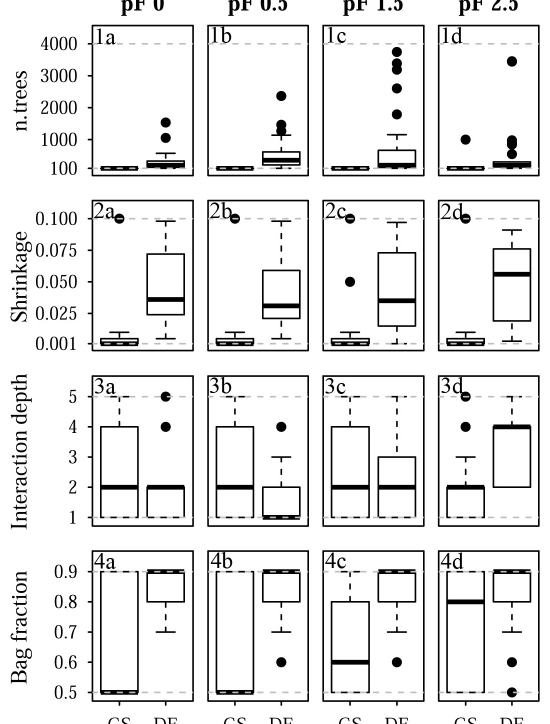
Figure 11. Selected tuning parameter values for Laipuna: (1a–d) n.trees, (2a–d) shrinkage, (3a–d) , interaction depth, and (4a–d) bag fraction for (1a, 2a, 3a, 4a) pF 0, (1b, 2b, 3b, 4b) pF 0.5, (1c, 2c, 3c, 4c) pF 1.5, and (1d, 2d, 3d, 4d) pF 2.5. Each boxplot is based on 25 values corresponding to the five-fold CV with five repetitions. Dashed gray lines indicate the chosen optimization limits. GS refers to grid search, and DE refers to the differential evolution